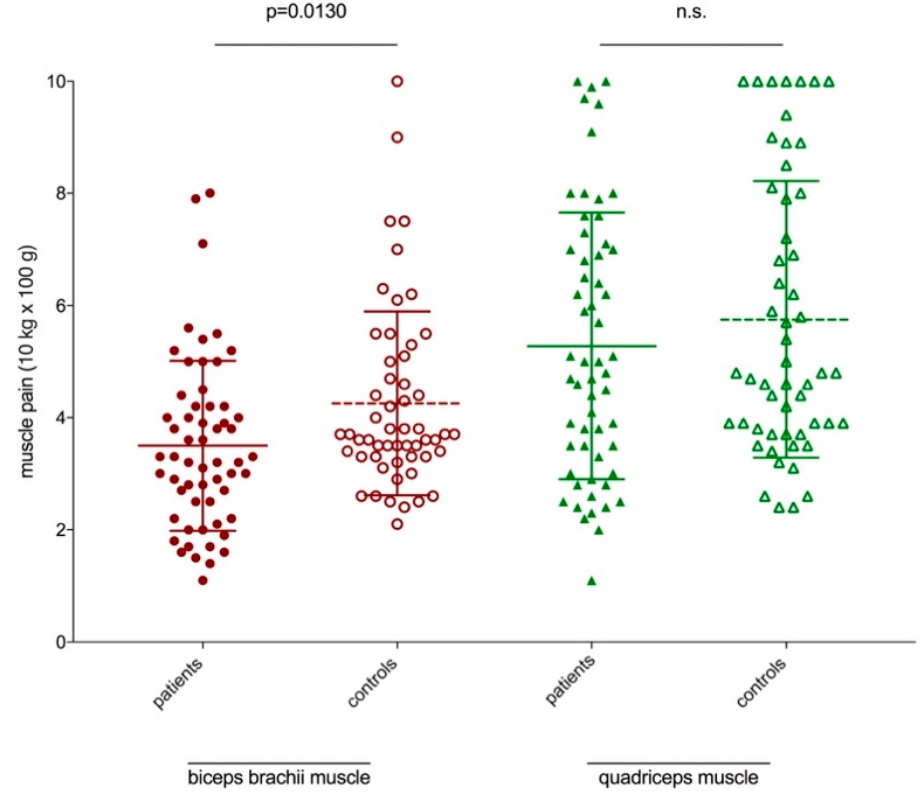
Figure 1. Pressure pain detection threshold measurement of patients (filled forms) and controls (open difference between patients and controls (p = 0.0130) in the biceps brachii muscle. Graphs show mean with standard deviation (SD), analysis using unpaired t-test.